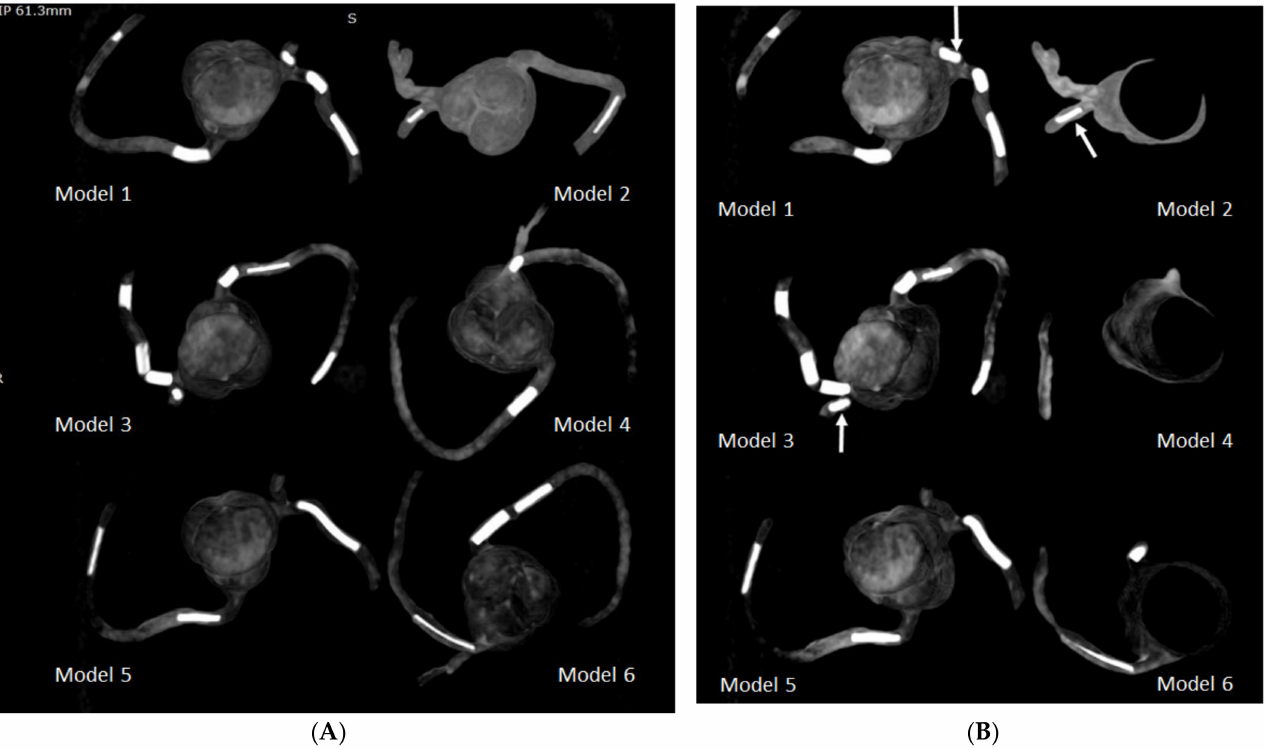
Figure 8. Maximum-intensity projection (MIP) images showing the calcified plaques in six 3D-printed coronary models. ( A ) Coronal MIP view showing these calcified plaques. ( B ) Oblique MIP view showing the plaques more clearly in the left circumflex coronary artery (arrows) in model 1 (plaque 3), model 2 (plaque 6), and model 3 (plaque